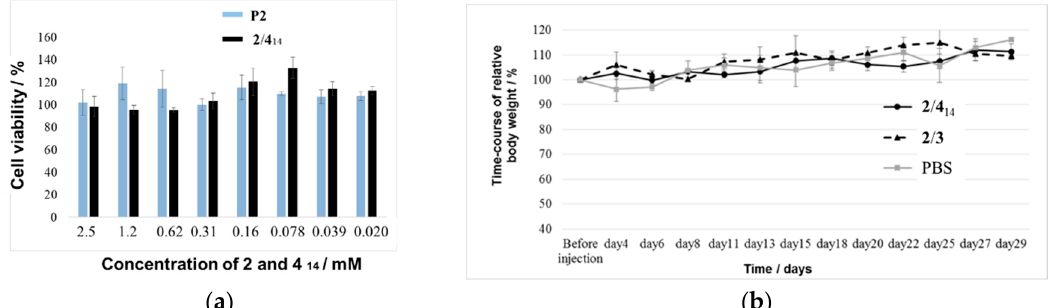
Figure 6. ( a ) In vitro cell viability of 2 / 4 14 and P2 by using the CCK-8 kit after incubation for 24 h at 37 ◦ C under 5% CO 2 and ( b ) in vivo toxicity of 2 / 4 14 for healthy ICR mice weight (three mice for each of 2 / 4 14 , 2 / 3 and control PBS) as a function of time after injection of 200 µ L of mixed micelles (40 mM for each component) in PBS or PBS. See the Supplementary Information for experimental details.